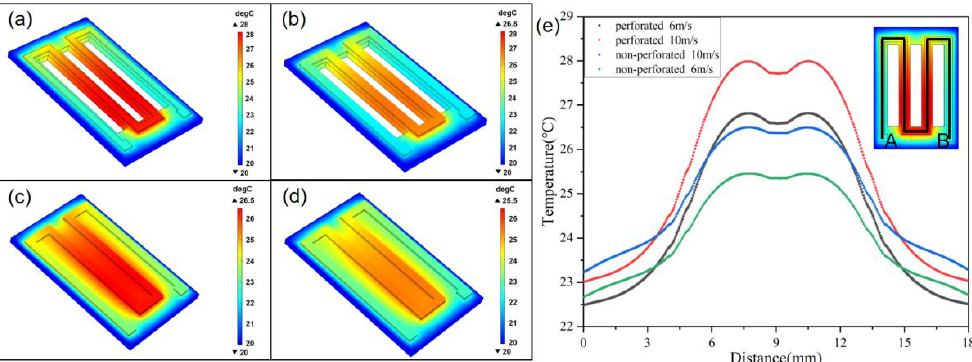
Figure 3. Comparison of the heat transfer properties between the non-perforated sensor and perfo- rated sensor. ( a ) The temperature distribution of the perforated sensor at a respiratory airflow speed of 10 m/s and ( b ) at a speed of 6 m/s. ( c ) The temperature distribution of the non-perforated sensor at a speed of 10 m/s and ( d ) at a speed of 6 m/s. ( e ) The temperature distributions from point A to B for non-perforated and perforated sensors at different respiratory airflow rates.